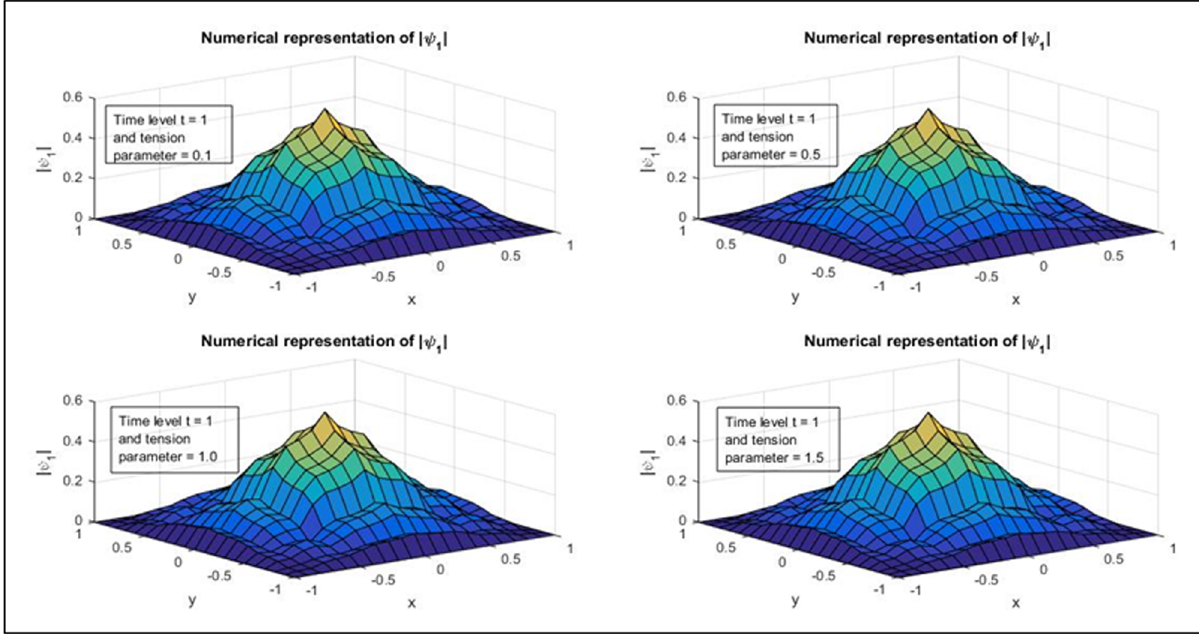
Figure 15: Graphical representation of numerical solution of fi rst - wave amplitude at = t 1 for parameters, = N 21 , = t Δ 0.0001 , = α 0.1 and for di ff erent values of tension parameter τ